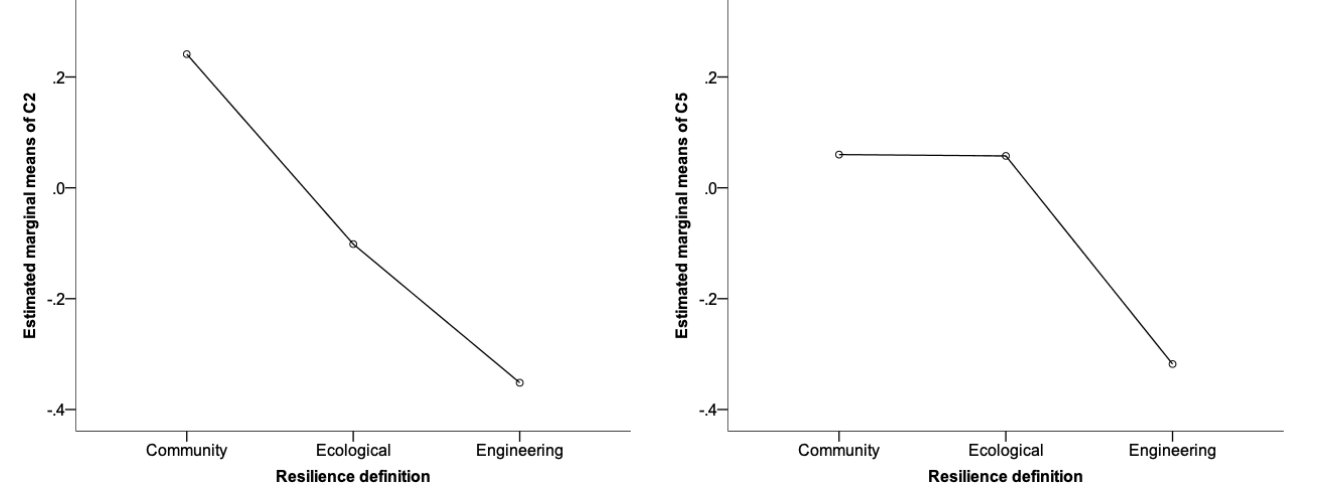
Fig. 6 . The variation in favored strategies based on participants’ choice of definitions of resilience. C2: Decentralized water governance and C5: Adaptation to floods are significantly different between groups ( p < 0.05) (see Appendix 1 for more details). The other three components (C1,C3, and C4) did not vary significantly by definition. Note: the estimated marginal mean refers to the mean response for each factor adjusted for any other variables in the model.